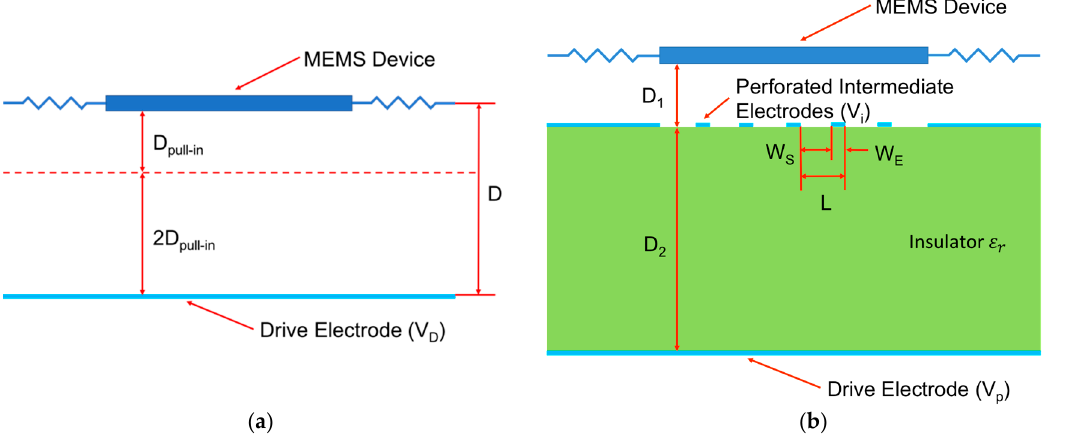
Figure 1. ( a ) Conventional electrostatic actuator; ( b ) New topology with perforated intermediate electrode.